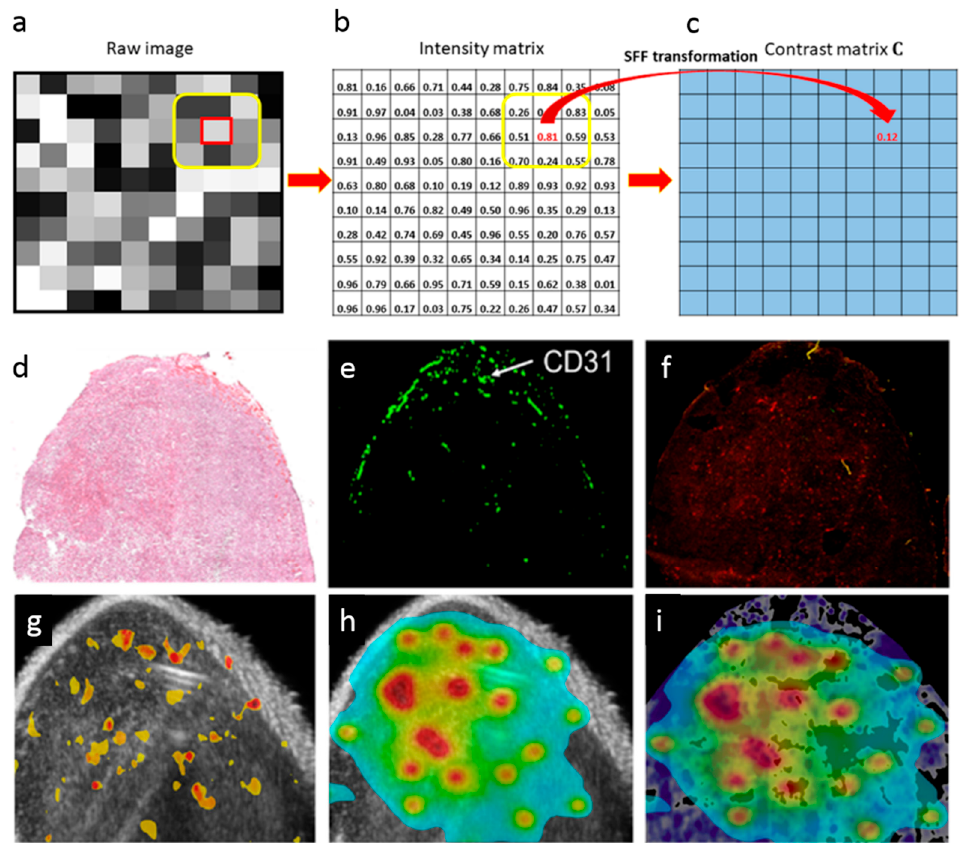
Figure 10. ( a – c ) General procedure of the spectral Fiedler field (SFF) method which includes ( a ) a raw image in gray scale, ( b ) the matrix representation of ( a ), and ( c ) the resulting contrast matrix. Using the matrix from of each gray scale image, the method is applied to a small region centered at every single pixel, generating the contrast matrix, which is then processed using a low pass filter for removing noise. The final matrix represents the SFF map. ( d ) Hematoxylin and eosin image of colon tumor. ( e ) Pattern obtained using CD31 endothelial cell marker. ( f ) Fluorescence of the drug in tumors. ( g ) SFF map of echogenic liposomes enhanced ultrasound contrast in tumor areas displaying a positive response for CD31 endothelial cell marker. ( h ) Relative drug diffusion considering the positive regions in SFF map. ( i ) Normalized distribution of doxorubicin combined with doxorubicin fluorescence image. Purple shades refer to doxorubicin fluorescence while blue-red corresponds to the spectral shades of doxorubicin distribution. Reprinted from [175] under a CC BY 4.0 License. Copyright Liu, C.,